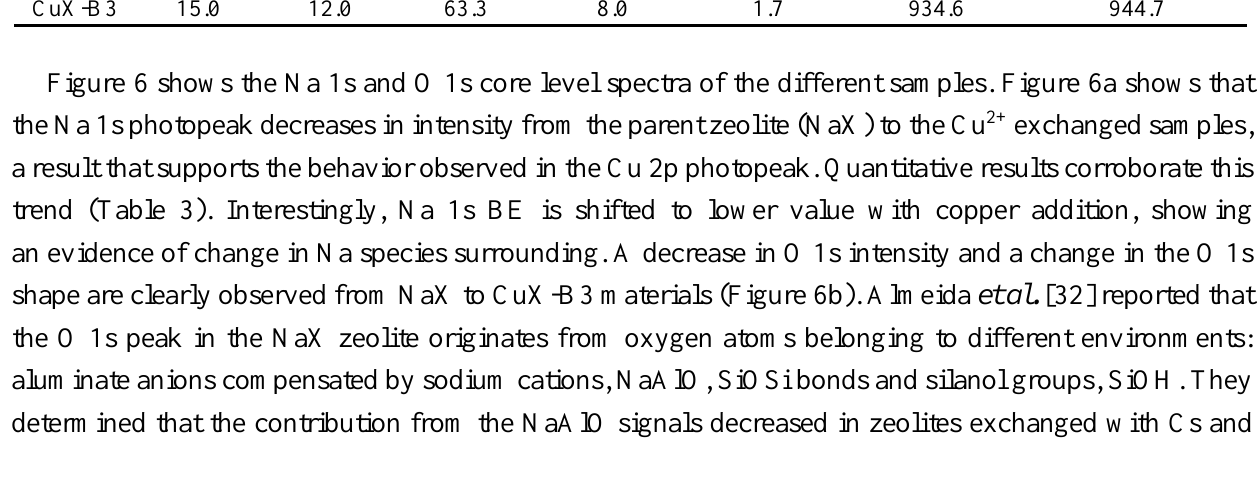
Table 3. Surface composition (at. %) of the NaX and copper-exchanged zeolites, Cu 2p 3/2 BE (eV) and satellite (Sat) Cu 2p 3/2 BE (eV) in the copper-exchanged zeolites. Sample Si (at. %) Al (at. %) O (at. %) Na (at. %) Cu (at. %) Cu 2p 3/2 (eV) Sat Cu 2p 3/2 (eV) NaX 13.4 9.6 - - CuX-B1 14.3